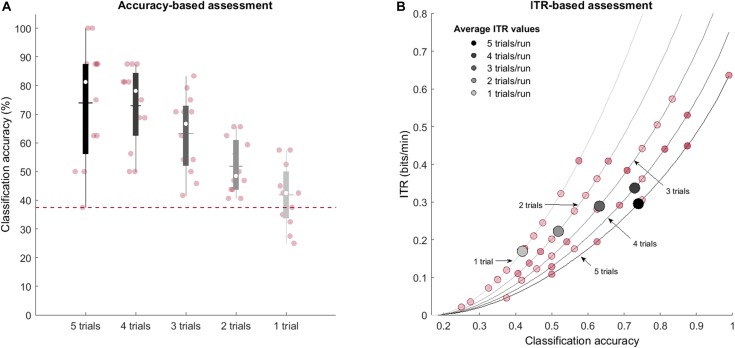
Effect of the number of trial repetitions on obtained decoding accuracy (individual and group results). (A) The box-plot shading depicts the number of repetitions used for decoding: from five trials (black) to a single trial (light gray). Median values are represented by the white circles, while the mean values are indicated with the horizontal lines. The y-axis represents the accuracy (%) achieved by the participant. The red, dashed line shows the chance-level defined by the cumulative multinomial distribution. The number of trials used to decode each run influences the decoding process, but mean- and several single-subject accuracies remain above chance level even with a single trial. (B) Average (gray-scale markers) and single-subject (red markers) ITR values (bits/min) for different number of trials as a function of achieved classification accuracies. Lines represent the theoretical values the ITR can take as a function of the number of classes, trial duration and accuracy.